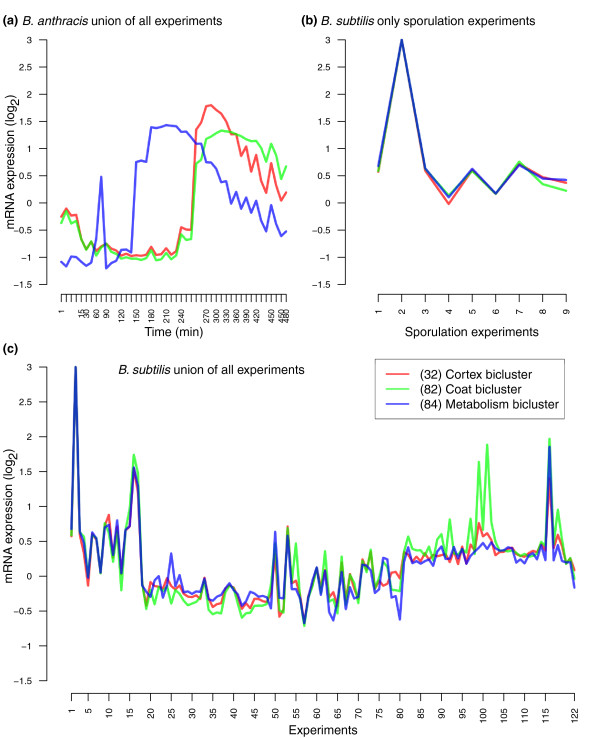
Expression profiles of three partially conserved sporulation biclusters, identified by the multi-species analysis of B. subtilis and B. anthracis. Bicluster 84 (blue line) is composed primarily of genes involved in metabolic functions during sporulation, bicluster 82 (green line) includes primarily genes encoding spore coat proteins, and bicluster 32 (red line) contains genes involved in spore cortex formation and activation of the σ factors required for the latest stages of sporulation. (a) The B. anthracis biclusters display distinct profiles, revealing a temporal aspect not present in the B. subtilis dataset. The B. subtilis biclusters all follow the same expression profile (that is, similar expression over nearly every experimental condition included in the dataset), as shown for (b) only sporulation experimental conditions (with abscissa corresponding to: 1) hour 2 sigF; 2) hour 2.5 sigE; 3) hour 3.5 gerR; 4) hour 3.5 spoIIID; 5) hour 4 sigG; 6) hour 4.5 sigK; 7) hour 5 spoVT; 8) hour 5.5 gerE; 9) hour 6.5 gerE) and (c) all experimental conditions within the three biclusters.